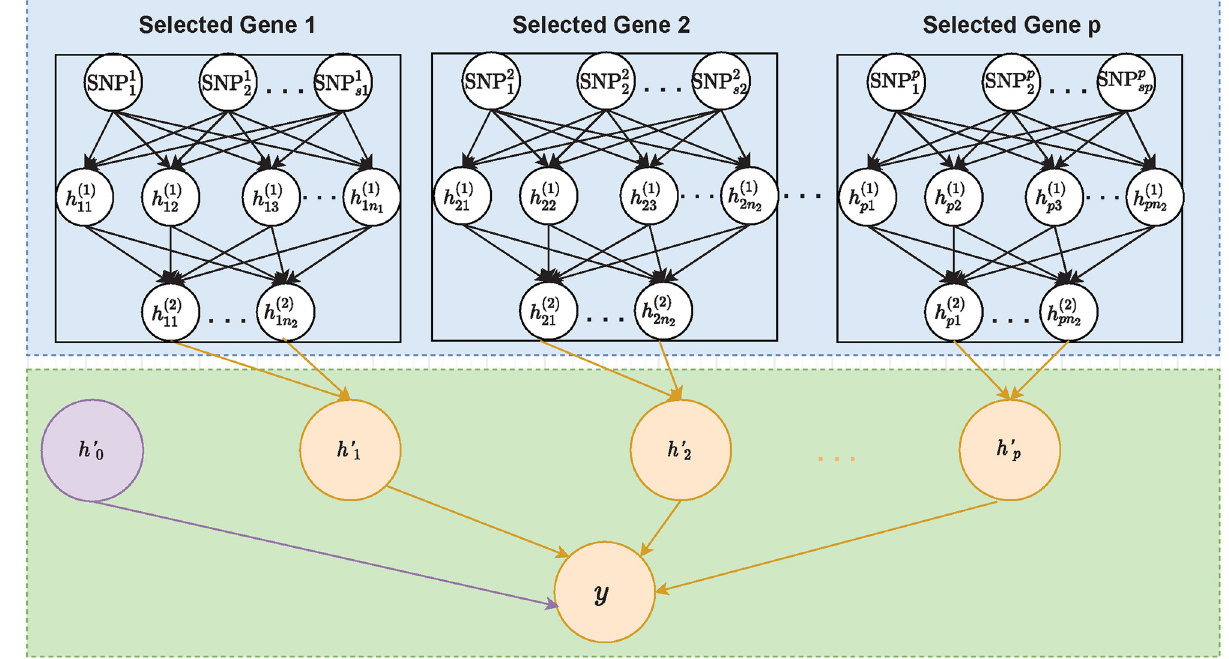
Fig 2. An illustrative figure of the architecture of the proposed transfer-learning-based deep network, where no interaction between genes is assumed. The blue box : DNN models obtained from feature screening and the corresponding parameters are fixed. The green box : the newly added hidden layers, a background node, and their associated parameters that need to be